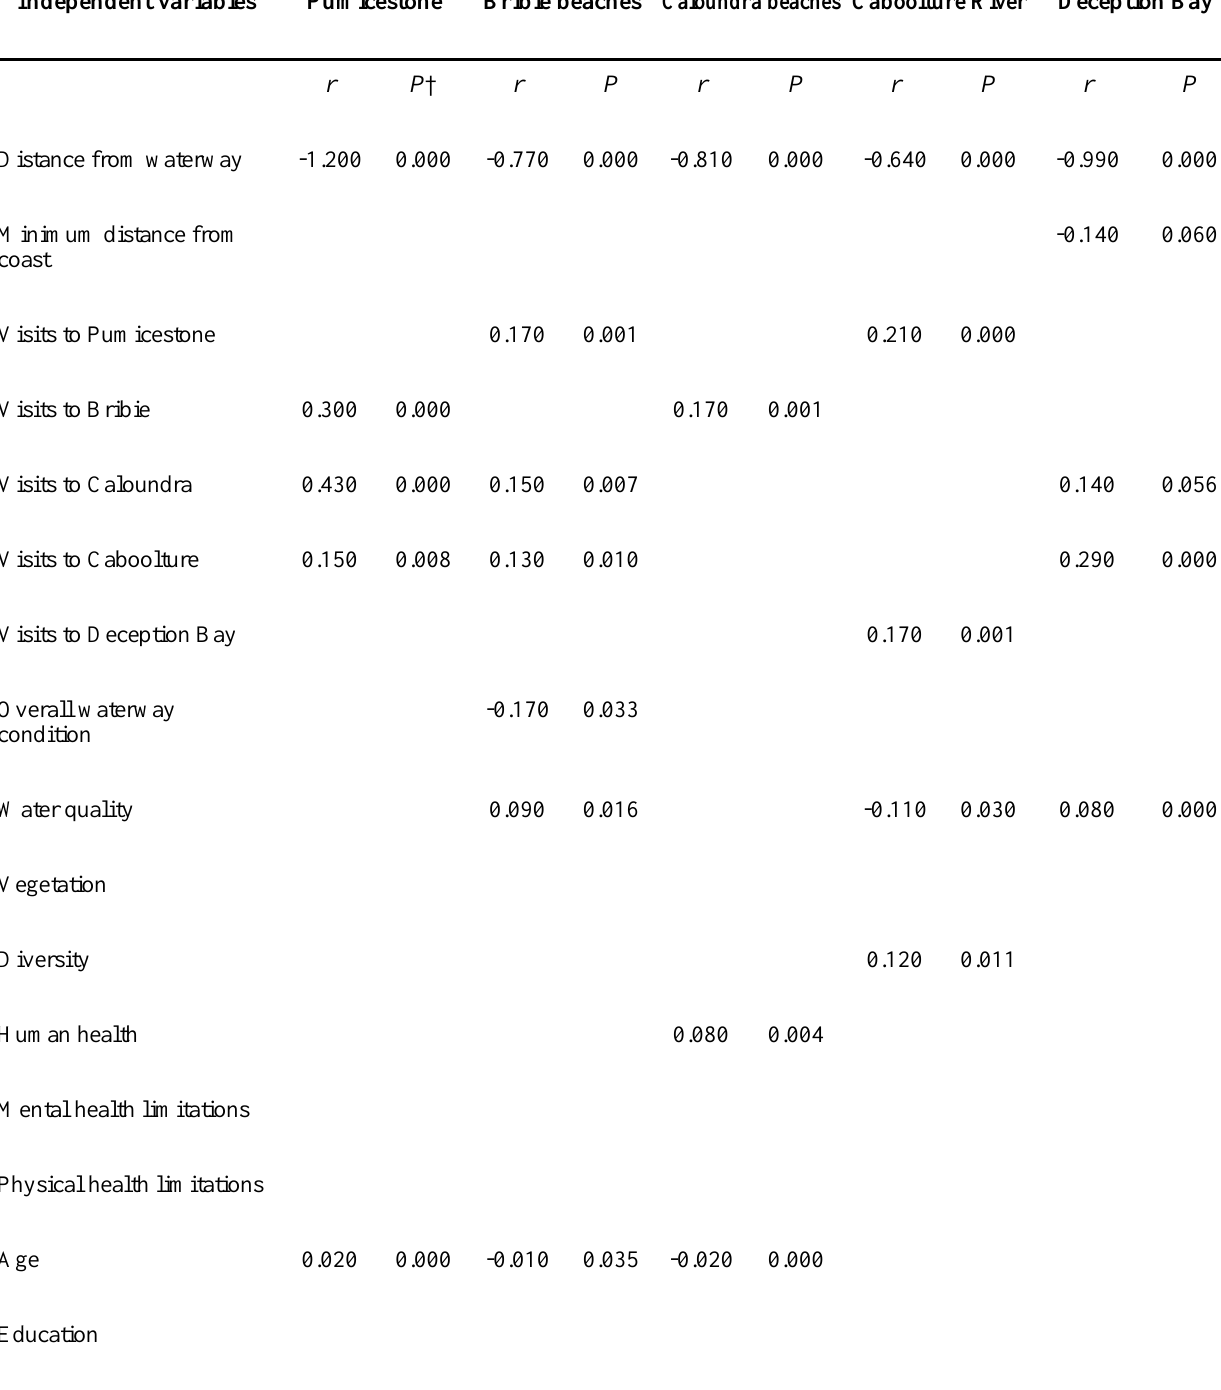
Table 7. Regression coefficients ( r ) and p values for recreational visits to waterways, Pumicestone